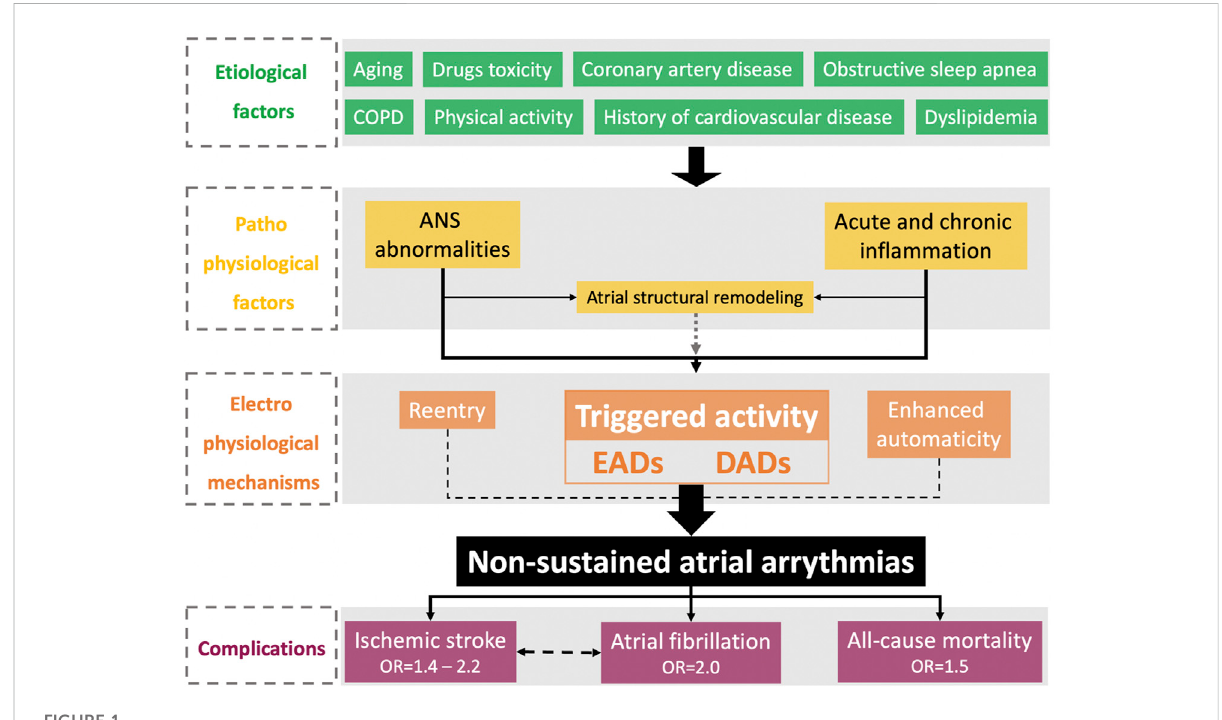
Physiopathological and epidemiological features of nonsustained atrial arrhythmias. ANS, autonomic nervous system; COPD, chronic obstructive pulmonary disease; DADs, delayed afterdepolarizations; EADs, early afterdepolarizations; OSA, obstructive sleep